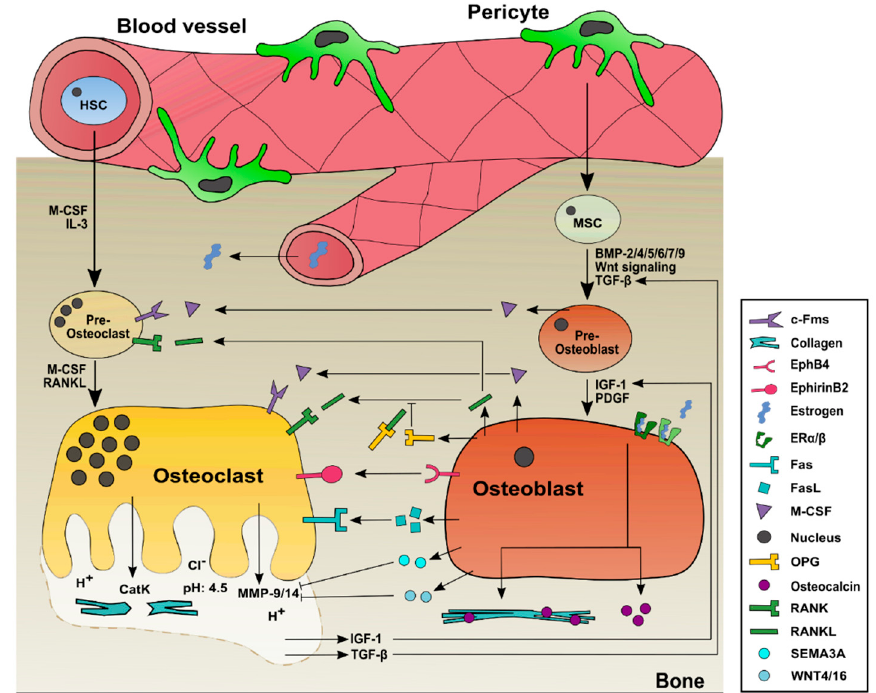
Figure 1. Bone formation, activation, and differentiation of osteoblasts and osteoclasts in healthy individuals. Bone-resorbing osteoclasts derive from hematopoietic stem cells (HSCs) with an intermediate state of pre-osteoclasts. Important factors for the differentiation of HSCs towards osteoclasts are M-CSF, interleukin-3, and RANKL. Mature osteoclasts release cathepsin K and MMPs at the ruffled border into the sealing zone where bone is resorbed and factors such as insulin-like growth factor 1 and TGF- β are released. These factors are needed for osteoblastogenesis. Mesenchymal stem cells, derived from pericytes, need BMP-2/4/5/6/7/9, Wnt signaling, and TGF- β to differentiate towards pre-osteoblasts, followed by insulin-like growth factor 1 and platelet-derived growth factor release, which are necessary to form mature bone-synthesizing osteoblasts. Estrogen is necessary for the differentiation and activation of osteoblasts as well. It binds to its estrogen receptors- α / β (ER α / β ) and activates collagen 1 and osteocalcin production in mature osteoblasts. Both cell types play a major role in bone homeostasis and exchange factors to activate each other. RANKL and M-CSF are produced by osteoblasts and are needed for the differentiation and activation of osteoclasts. OPG is also produced by osteoblasts but is a decoy for RANKL, therefore inhibiting osteoclast activation and differentiation. FasL, ephirins, semaphorins, and WNTs also play a role in cell communication between osteoblasts and osteoclasts, as